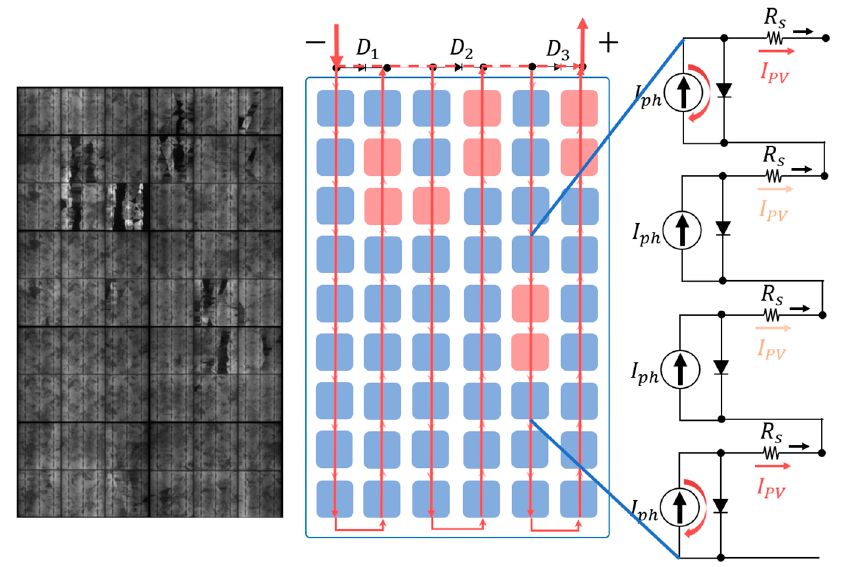
Figure 6. I–V and V–P curves before and after power recovery for sample 190 B.